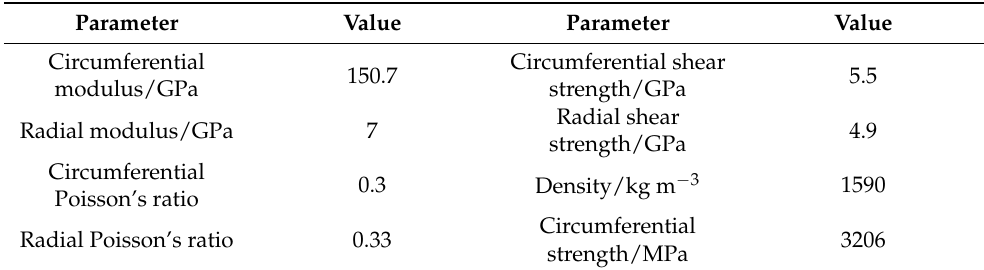
Table 1. Mechanical properties of carbon fiber T700/epoxy resin.